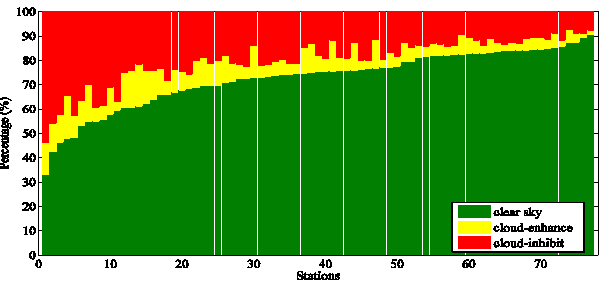
Figure 5. The frequency histogram of the effect of cloud on pollutants diffusion. The “ clear sky ” indicates there is no cloud in the boundary layer, otherwise, boundary layer is cloud-taped; “ cloud-enhance ” means clouds stimulate turbulence in the cloud-capped conditions; “ cloud-inhibit ” indicates the case that the inversion in the cloud suppresses turbulence in the cloud-capped conditions. The stations are sorted by the value of clear sky percentage. Table 2. A summary of the comparison of the h con with h θ , h RH , h q , h N and h 0 , including correlation coefficient, bias and standard deviation. h con is the final consistent estimate of h which include the information of temperature, water vapour and cloud; h θ , h RH , h q , h N are the h derived from the individual standard of potential temperature ( θ) , relative humidity (RH), specific humidity ( q) and atmospheric refractivity ( N) respectively; h 0 indicates the h inte- grating the information of θ , RH, q and N which is a transition to the h con .